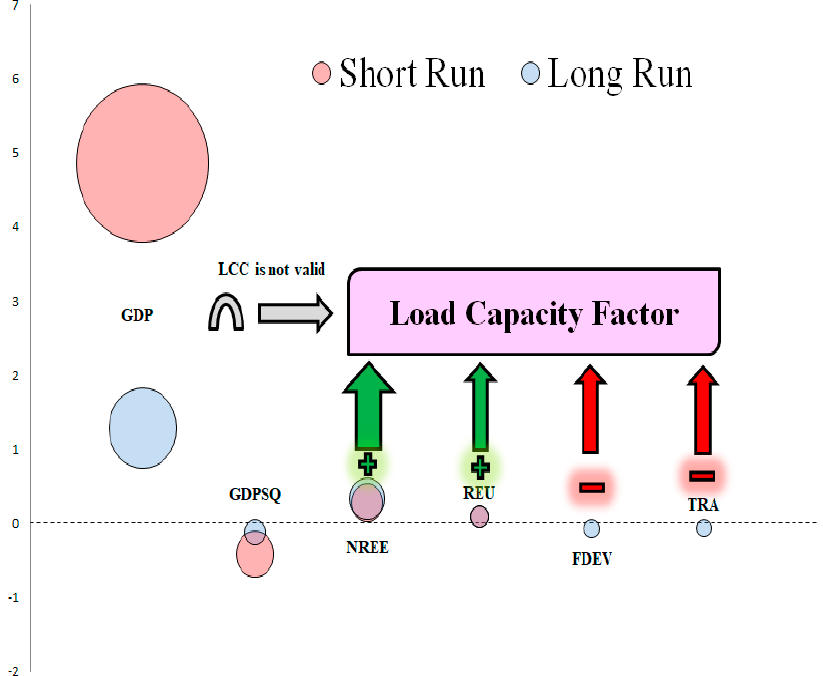
Figure 4. Summary of the results of DyARDLS approach. The y-axis represents the coefficients of the model expressed in absolute values. This also connotes the size of the bubbles. Note that − 1 and +1 changes in a variable have the same bubble size. The x-axis shows the explanatory variables.